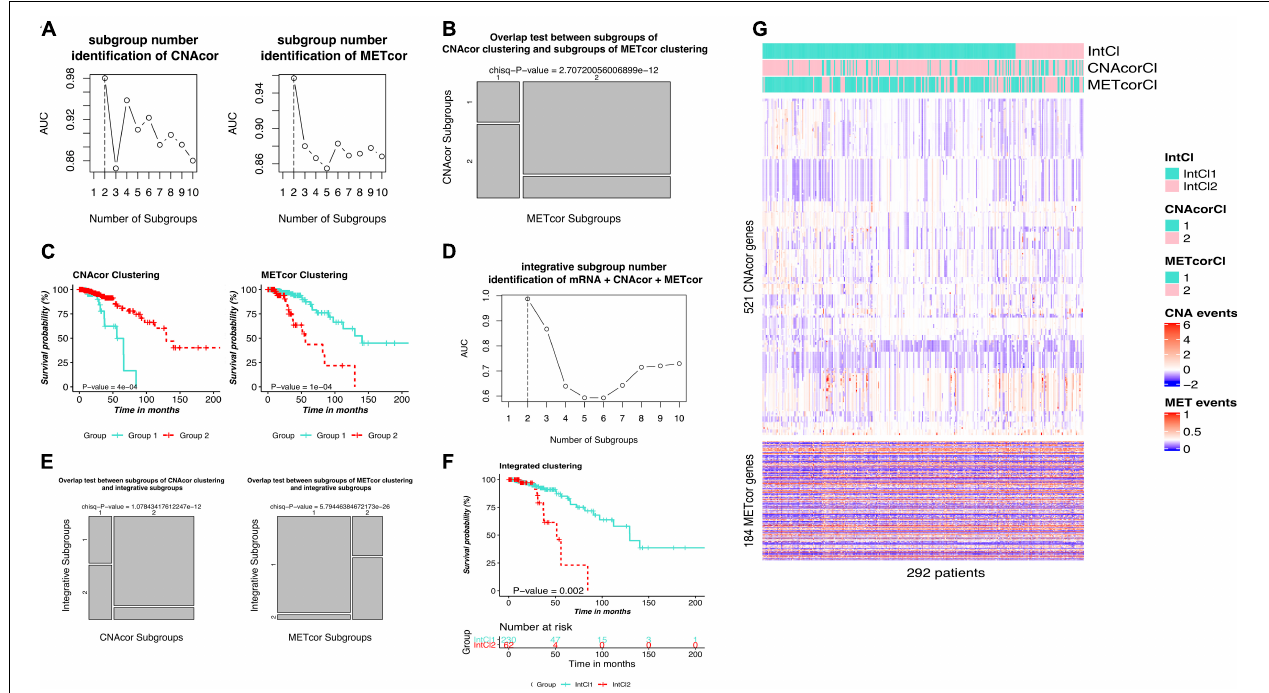
FIGURE 3 | Identification of BRCA molecular subgroups using individual CNAcor and METcor genes for single clustering and CNAcor, METcor, and mRNA for integrative clustering. (A,D) AUC values obtained for each value of k . The optimal k is the value has the highest AUC value. (A -left, A-right, D) are the results of CNAcor clustering, METcor clustering, and integrated clustering, respectively. (B) Overlap test between subgroups of CNAcor and METcor clustering. (E) Overlap test between IntCl subgroups and CNAcor (left), METcor (right). (C,F) Kaplan-Meier survival curves for CNAcor subgroups (C -left ) , METcor subgroups (C -right ) , and (F) integrated subgroups. (G) Heatmaps that show the expression patterns of CNAcor subgroups (mid) and METcor subgroups (bottom) from integrated analysis by PINSPlus. The colored bars indicate the patient subgroups identified by single clustering based on CNAcor (CNAcorCl; mid), METcor (METcorCl; bottom), and integrated clustering (IntCl;